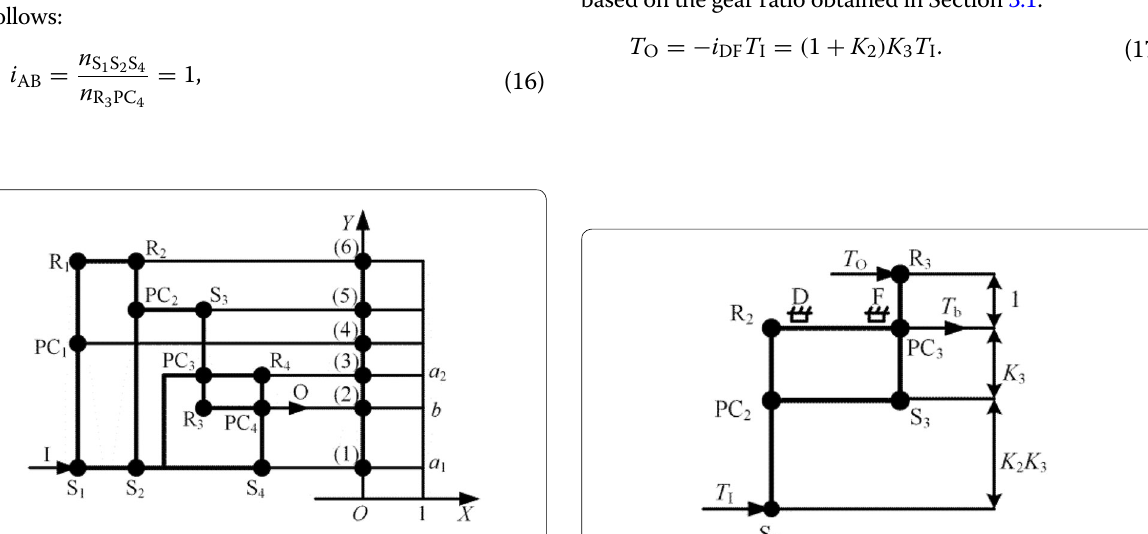
Figure 15 Equivalent lever speed diagram when A and B engaged together Figure 16 Torque analysis diagram when D and F